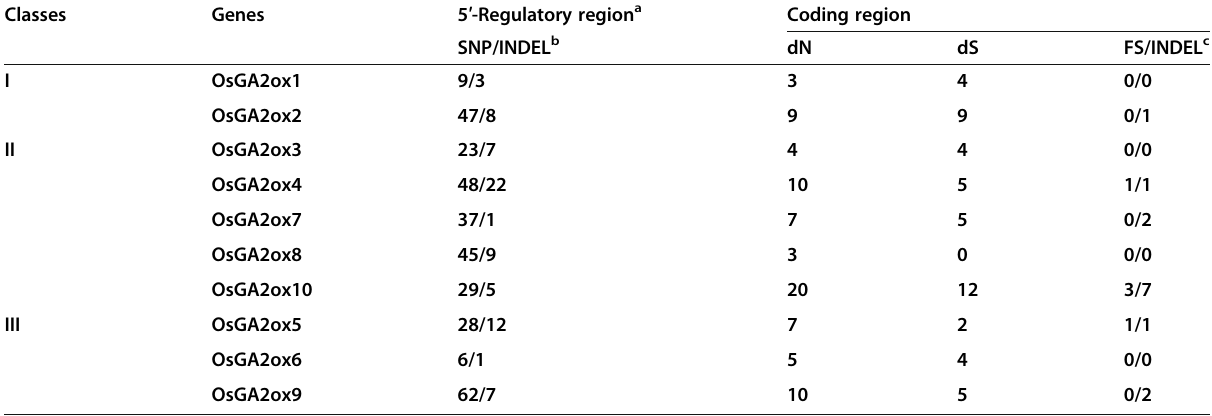
Table 2 Genomic sequence variations in the 5 ′ -regulatory and coding regions of OsGA2oxs analyzed with 4276 rice accessions